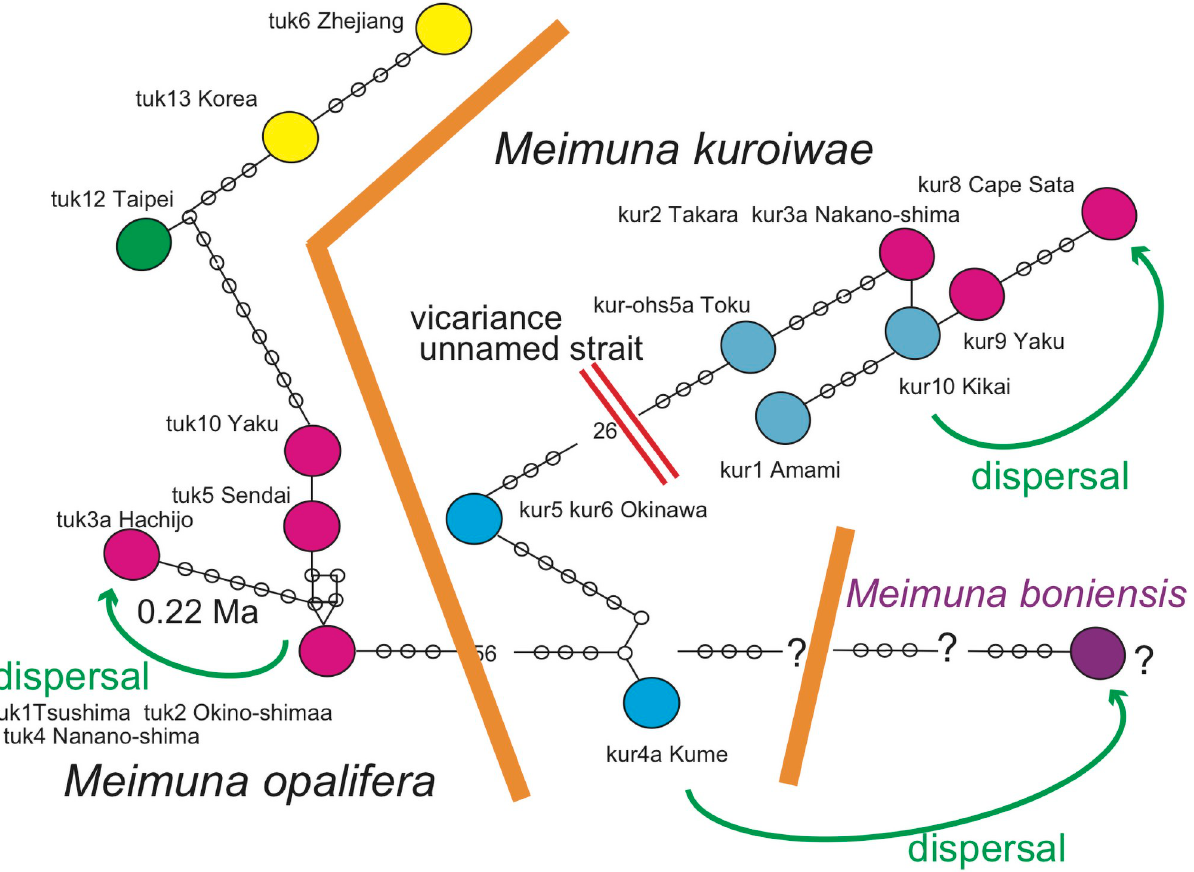
Fig 10. The haplotype network of Meimuna . Meimuna kuroiwae and M . opalifera constitute different networks. The M . kuroiwae network divided into the Okinawa and Amami-Tokara-Osumi-Kyushu networks, and the population of the southern end Kyushu may have been derived by dispersal from the southern islands. Meimuna boniensis may have been dispersed from Okinawa in ancient times (Nagata, 2019).